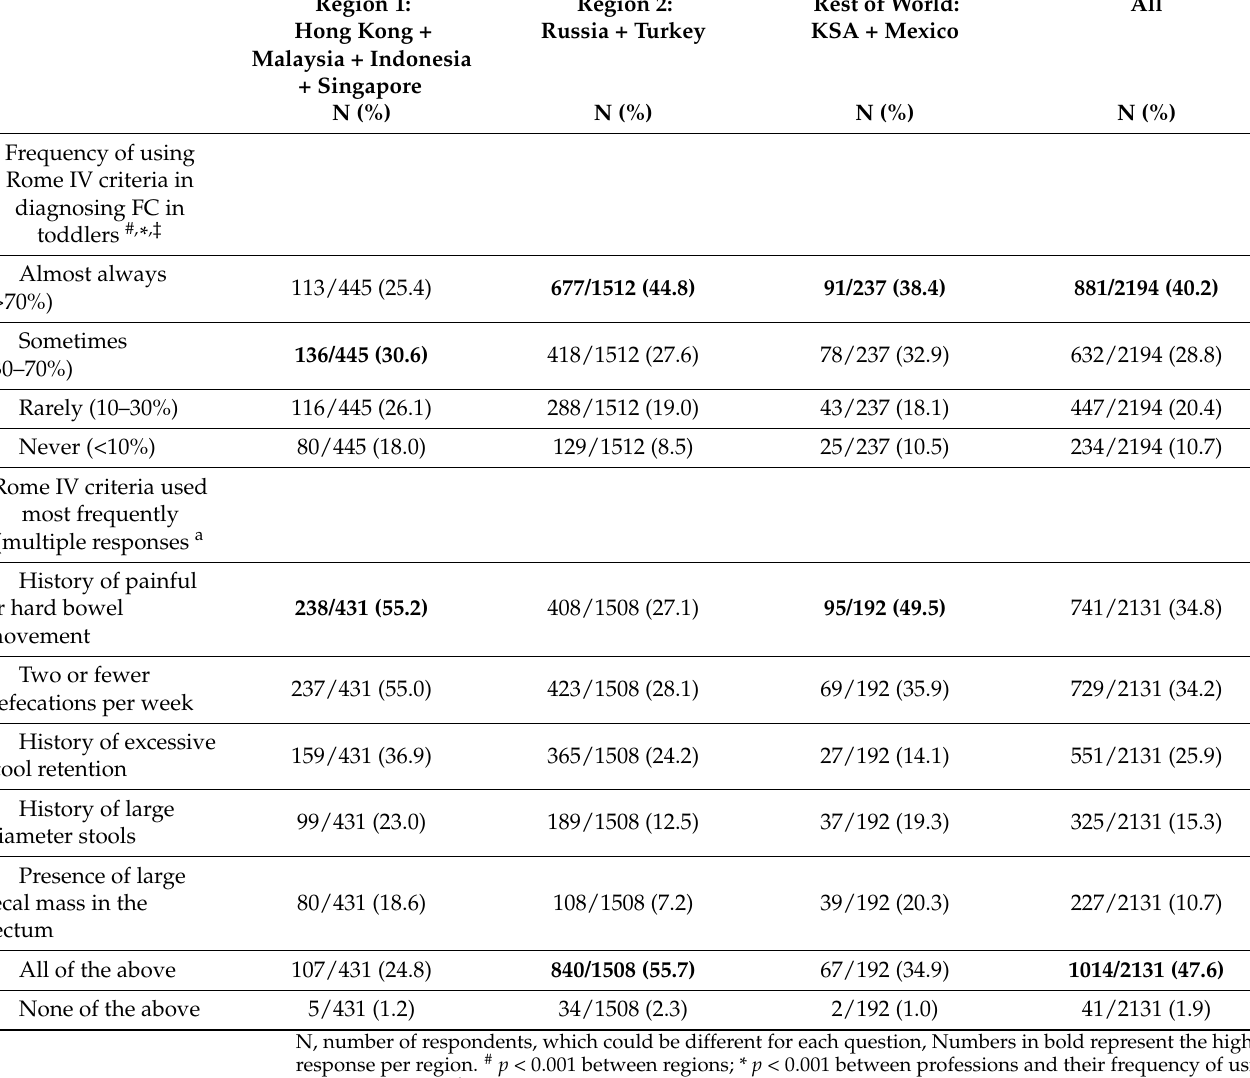
Table 1. The use of ROME IV criteria in the diagnosis of FC by regions. Region